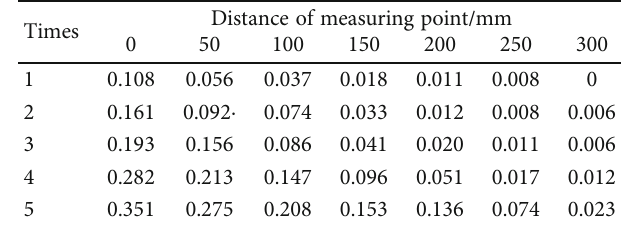
Table 3: The results of radial strain peak at each measuring point. Times